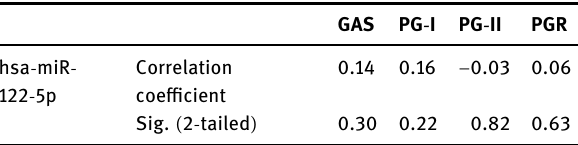
Table 2: Spearman ’ s correlation analysis between hsa - miR - 122 - 5p and other serum common